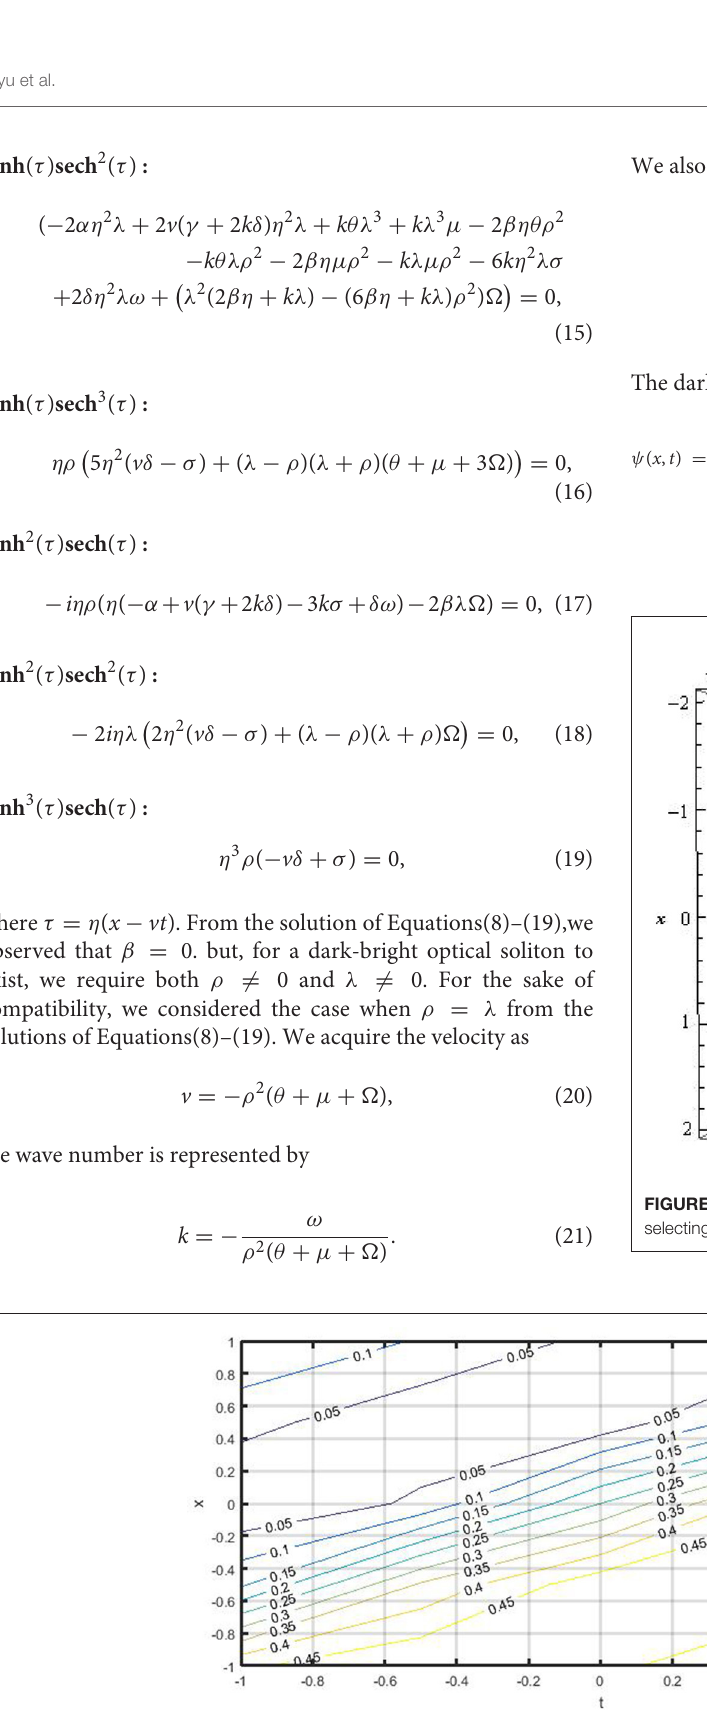
Frontiers in Physics |